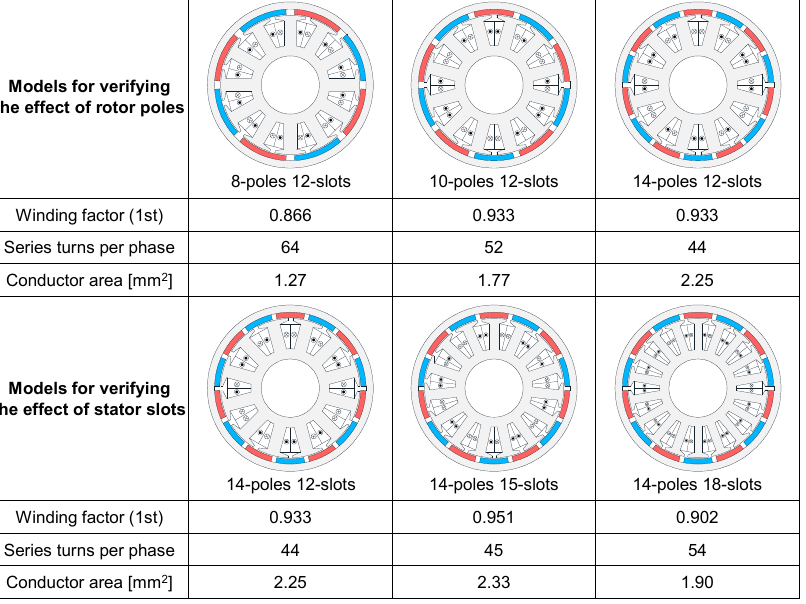
Figure 6. Analysis models for analyzing the effect of rotor poles and stator slots on the AC Joule